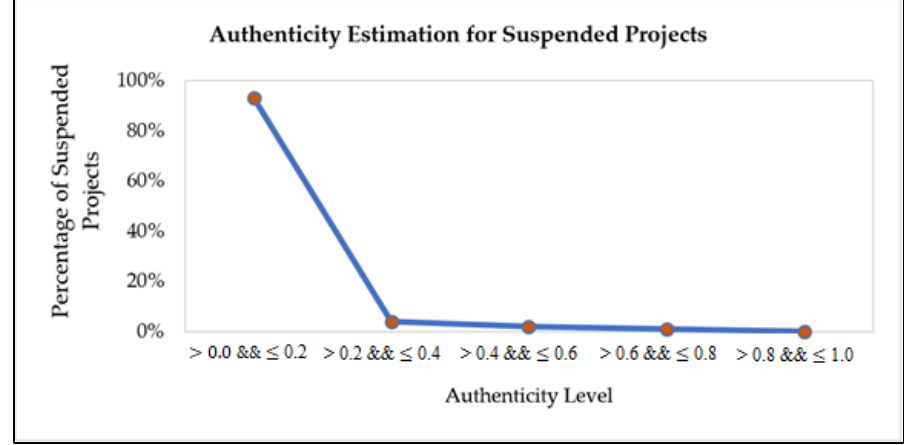
Figure 5. Authenticity estimation for suspended projects.